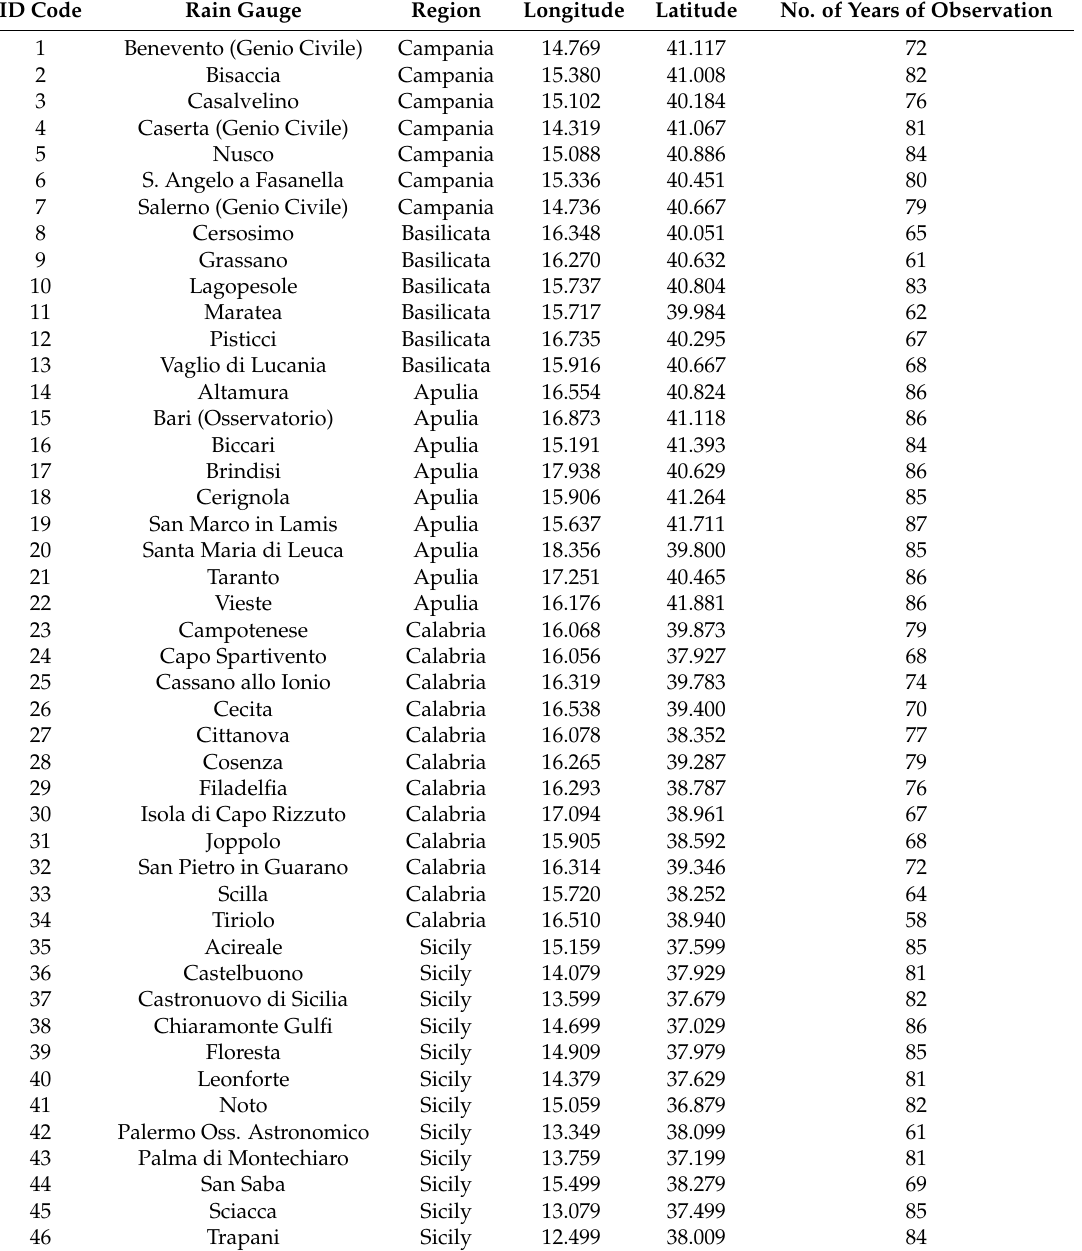
Table 1. Main details of the selected rain